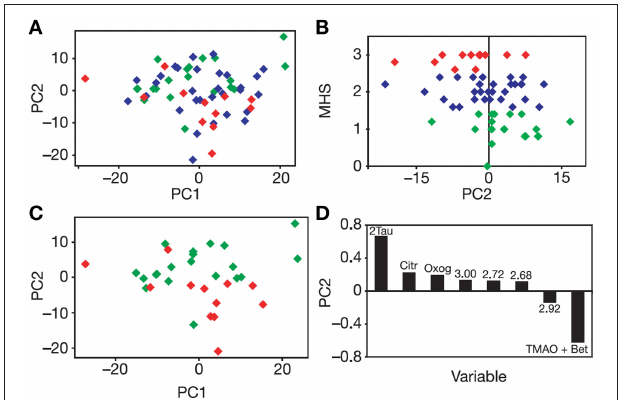
FIGURE 1 | Unsupervised PCA of the pre-dose urines of rats dosed subsequently with paracetamol. (A) PCA Scores plot of the multivariate analysis of the binned 600 MHz 1 H NMR spectra of the pre-dose rat urine. Each diamond corresponds to a different animal color-coded according to its mean, post-dose liver histopathology score (MHS): Class 1, no or minimal liver necrosis, green; Class 2, mild necrosis, blue, and Class 3, moderate necrosis, red. A partial separation is observed across PC2 between Class 1 and Class 3. (B) A plot of MHS against PC2: a weak but significant correlation is observed. (C) PCA Scores plot for the 1 H NMR spectra of the pre-dose rat urine, with the same color-coding as in (A) for Classes 1 and 3 only: the partial separation across PC2 is more readily observed. (D) The PCA loadings plot showing the bins of the 1 H NMR spectrum of the pre-dose urine that are responsible for the separations across PC2 and the direction of influence. Tau, taurine; Citr, citrate; Oxog, 2-ketoglutarate; TMAO + Bet, trimethylamine- N -oxide (TMAO) and betaine. Numbers correspond to the 1 H NMR chemical shifts (ppm) at the center of the bin responsible for the separation. Figure reproduced from Nature Publishing Group (Clayton et al.,